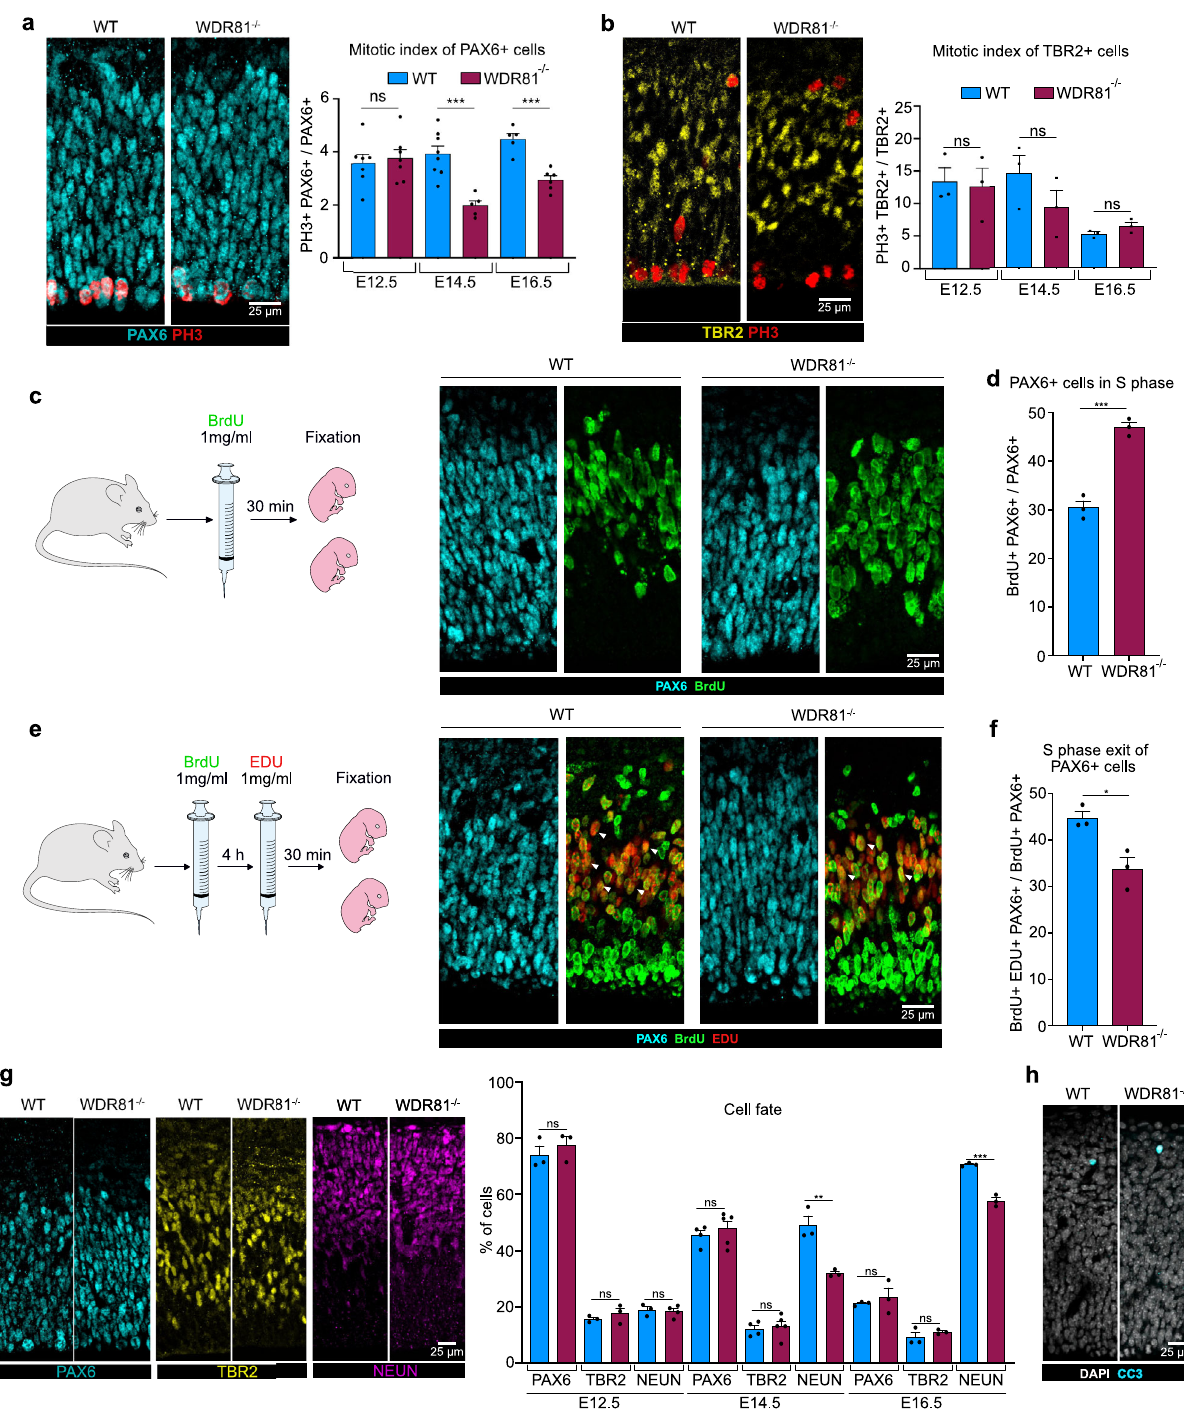
performed a double BrdU-EdU pulse, in order to measure the rate of S-phase exit. Mice were fi rst injected with BrdU, followed by a second injection with EdU 4 h later. This assay revealed a decreased proportion of cells that exited S phase (BrdU + /EdU − ) in WDR81 − / − brains, indicating a longer S phase in mutant radial glial progenitors (Fig. 2e, f). An alternative potential cause of reduced brain size is premature differentiation of progenitor cells. To test this, embryonic cortices were stained for PAX6 (radial glial progenitors), TBR2 (intermediate progenitors) and NEUN (neurons) at different developmental stages and the proportion of each cell population was measured. We did